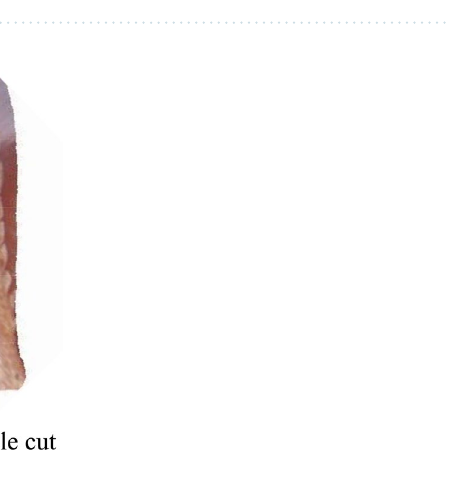
Figure 1. Diagrams of locomotor experimental materials, including the important dimensions (Lizard photo credit: Tao Liang).